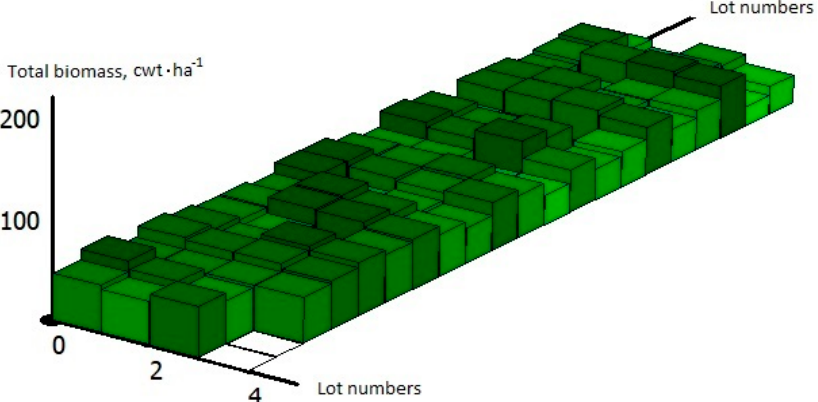
Figure 11. Distribution of the estimates of the total biomass of spring wheat sowing by elementary plots of the field.